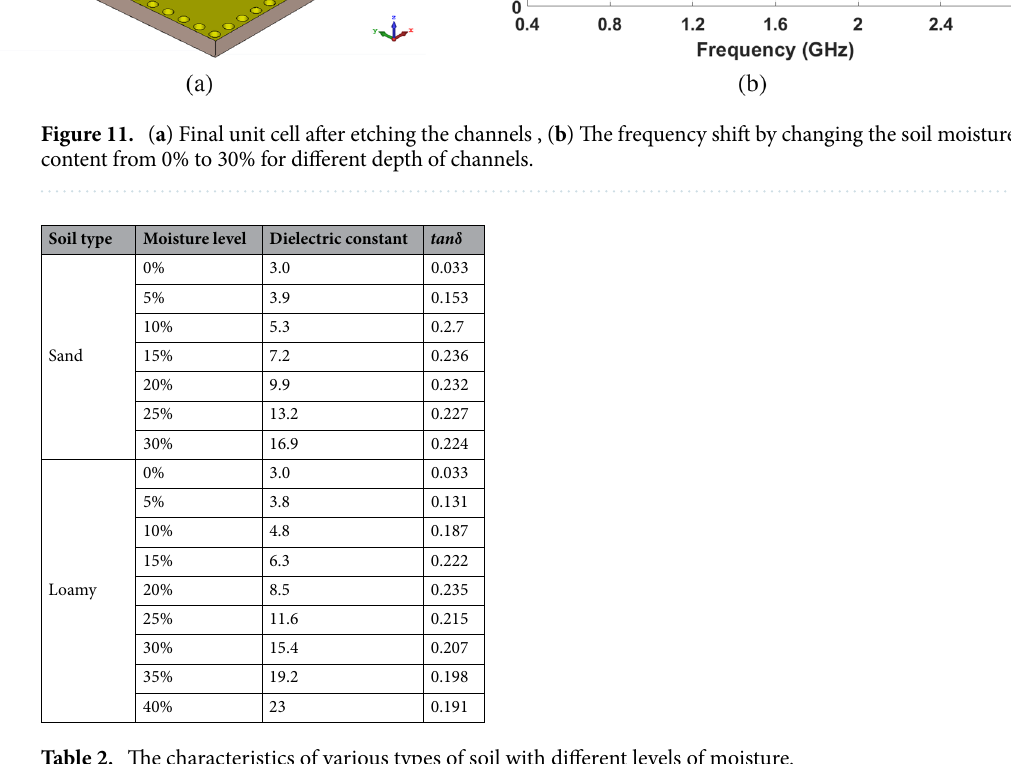
Table 2. The characteristics of various types of soil with different levels of